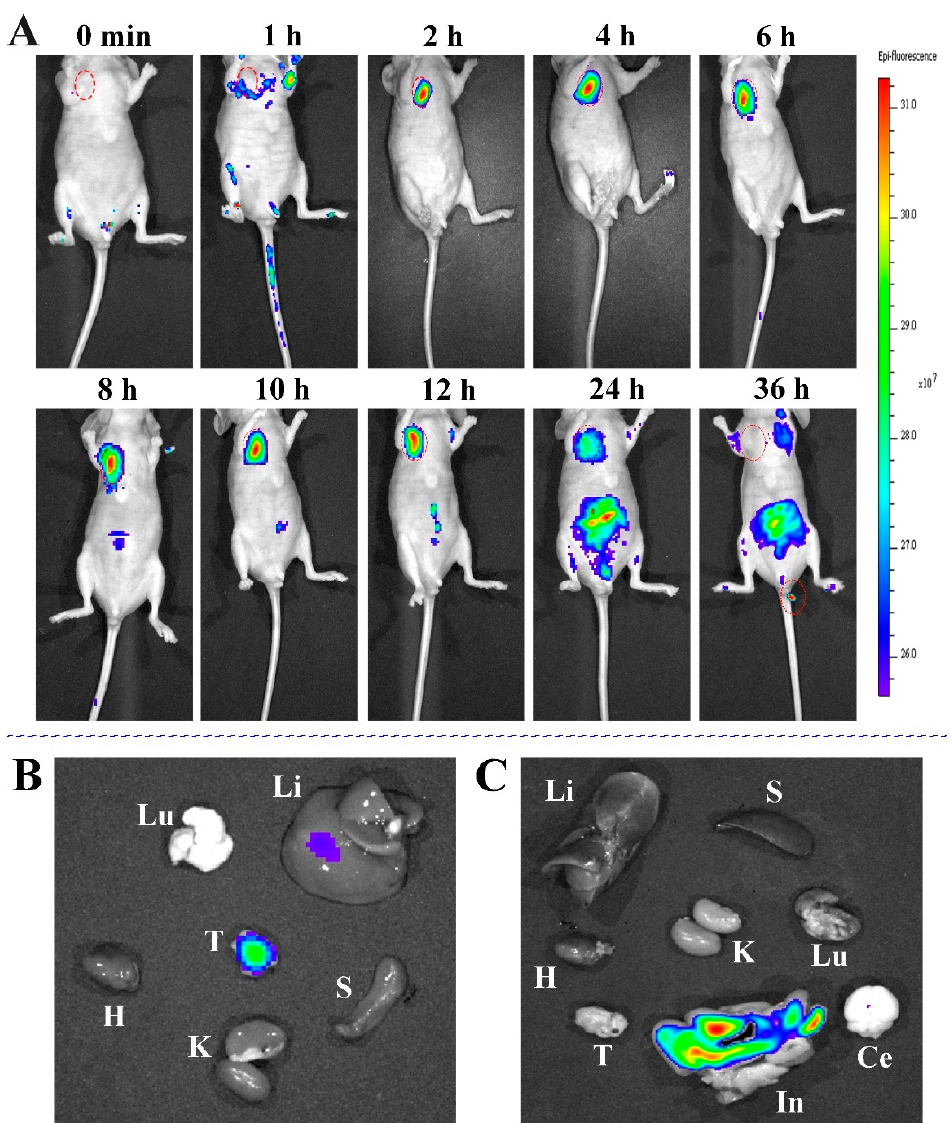
Figure 5. ( A ) In vivo near-infrared fluorescence images of 4T1 tumor-bearing nude mice by intravenous injection of Au/Gd@FA NCs at 0, 1, 2, 4, 6, 8, 10, 12, 24, and 36 h (Eex = 460 nm, Eem = 690 nm). (Tumor is indicated with a red dotted ellipse; stool is marked with a bold red circle). ( B ) The mice were sacrificed after injection for 8 h, the tumor (T, tumor), and major organs (Li, liver; K, kidney; S, spleen; Lu, lung; H, heart) for FL imaging ex vivo. ( C ) After injection for 36 h, the tumor (T, tumor) and major organs (Li, liver; K, kidney; S, spleen; Lu, lung; H, heart; In, intestine; Ce, cerebrum) for FL imaging ex vivo.